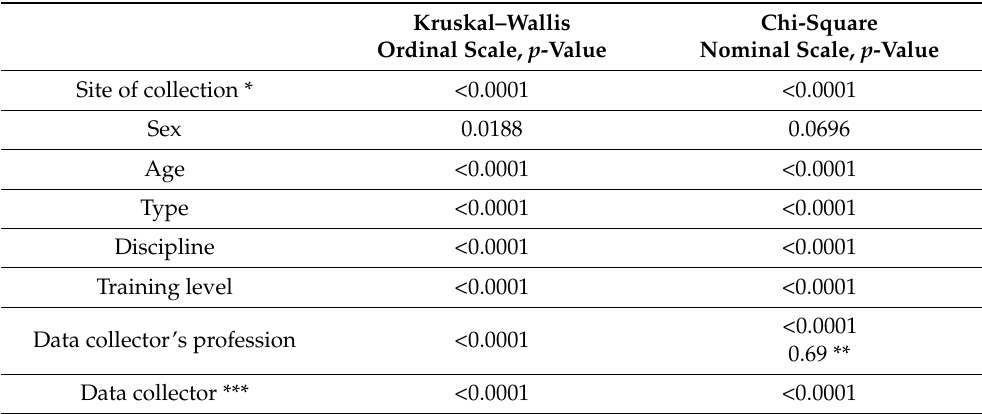
Table 2. Results of the bivariate analysis of the Body Condition Score and predictors. Kruskal–Wallis test, ordinal scale, and additional chi-square test, nominal scale (where data were sorted by <5 BCS (below ideal), 5–6 BCS (ideal), and >6 (above ideal)). A p -value < 0.05 indicates a significant difference